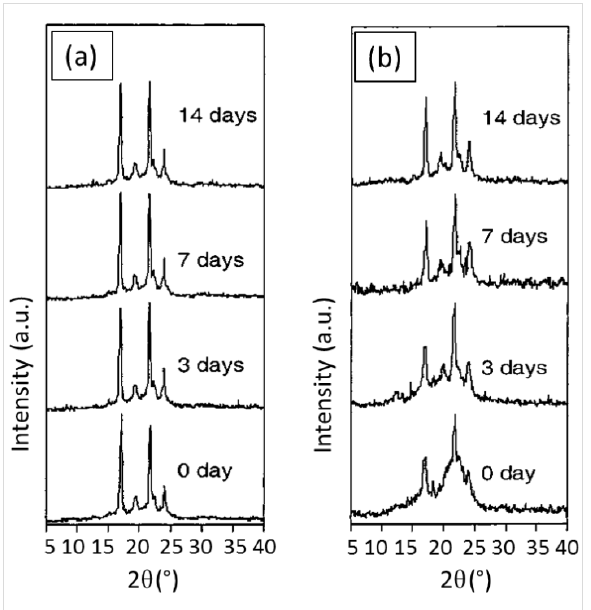
Figure 6: X-ray diffraction patterns of as-synthesized PCL- b -PLLA films (a) and coalesced PCL- b -PLLA films (b), after various enzymatic degradation times